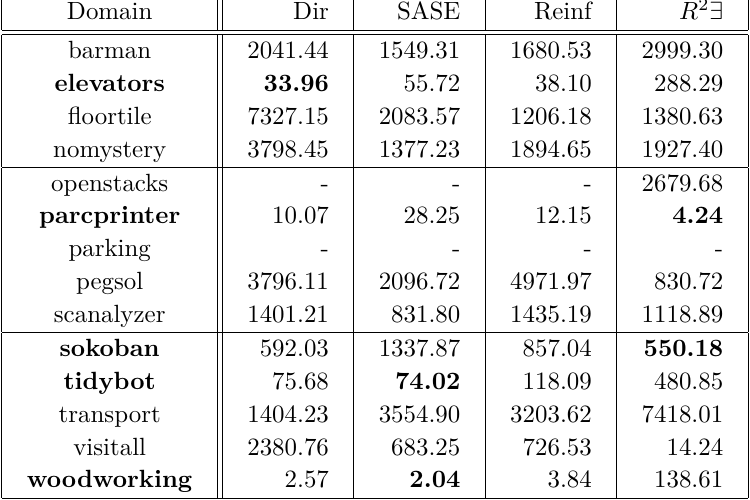
Table 3. The time in seconds required to solve all the problems that were solved within the time limit. The presented time is the sum of times the SAT solver alone required, formula generation time is not included. Domains with the same number of solved problems for each encoding are